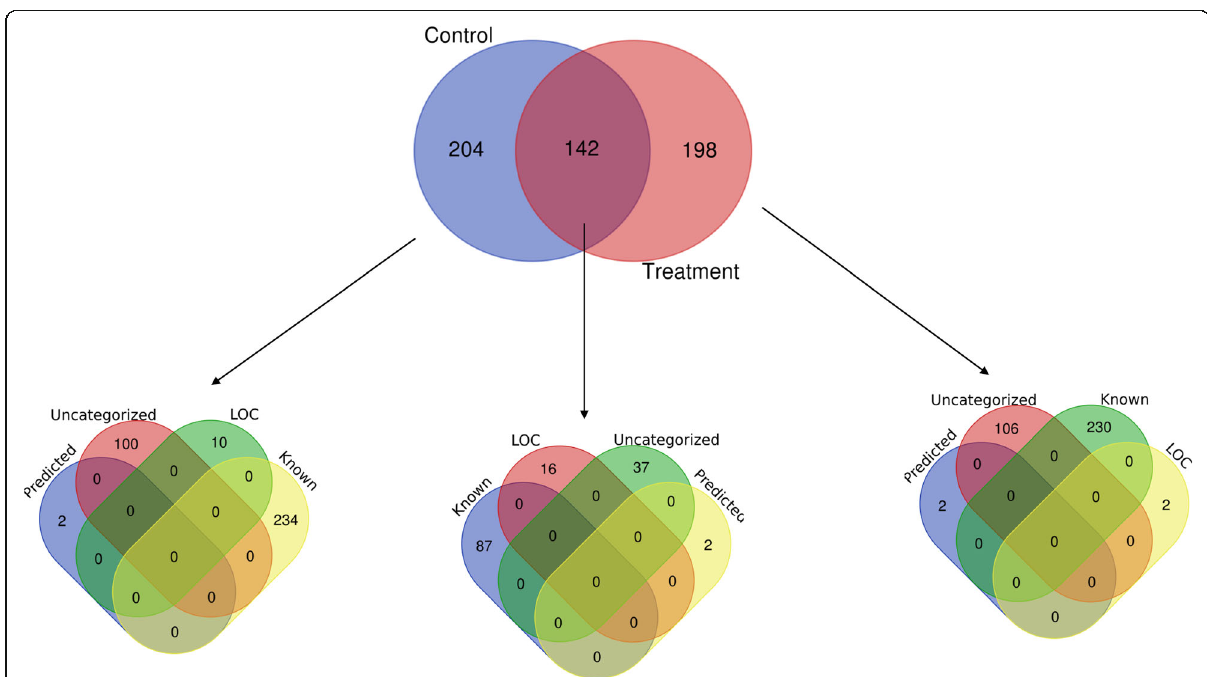
Fig. 3 Abundance of proteins in the liver of the rabbits. Control is the group not provided with the supplement while Treatment is the group supplemented with 500 mg Chlorella vulgaris biomass per kg body weight daily. The proteins were further categorized for each group as predicted which are proteins computationally predicted to present in the rabbits, the uncategorized which are protein with known sequence but which has not been characterized, LOC and Known proteins as found in the control and treatment groups as well as proteins common to both